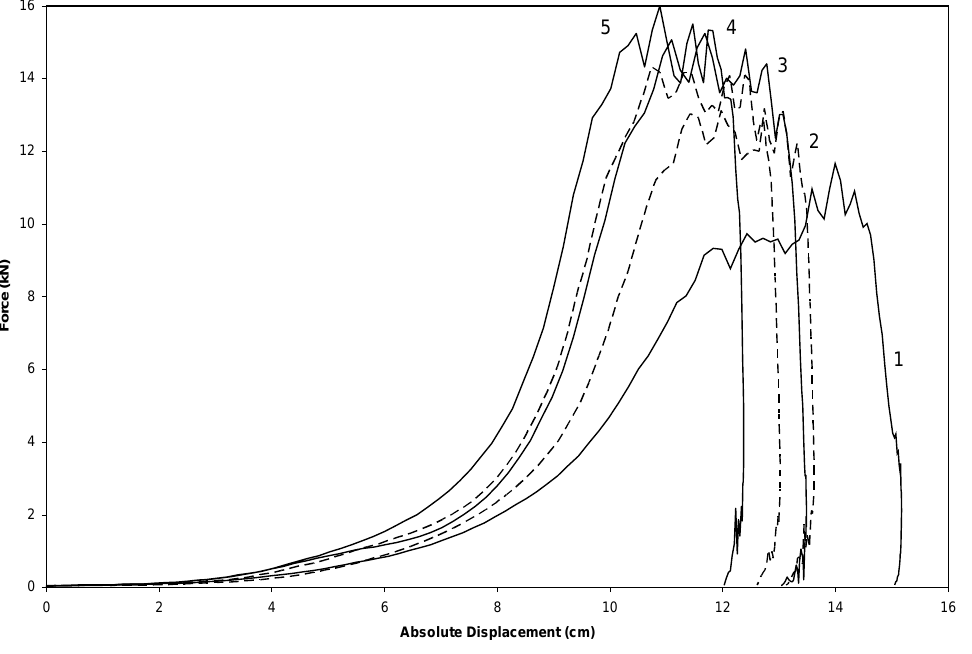
Fig. 8. Force versus elongation for new Amsteel II rope; weight = 289 N, height = 196